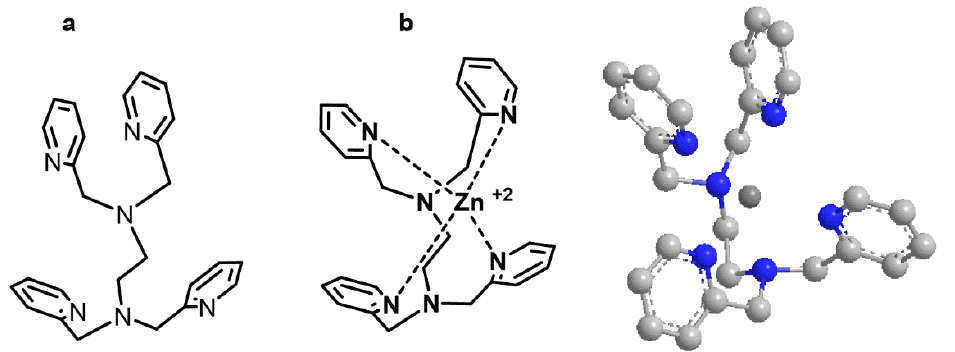
Figure 3. Structure ( a ) and three-dimensional study ( b ) of TPEN (N,N,N ′ ,N ′ -tetrakis (2-pyridinylmethyl)-1,2-ethanediamine). Light grey balls represent carbon atoms. Blue balls represent nitrogen atoms. Non linked dark grey balls represent zinc cations.